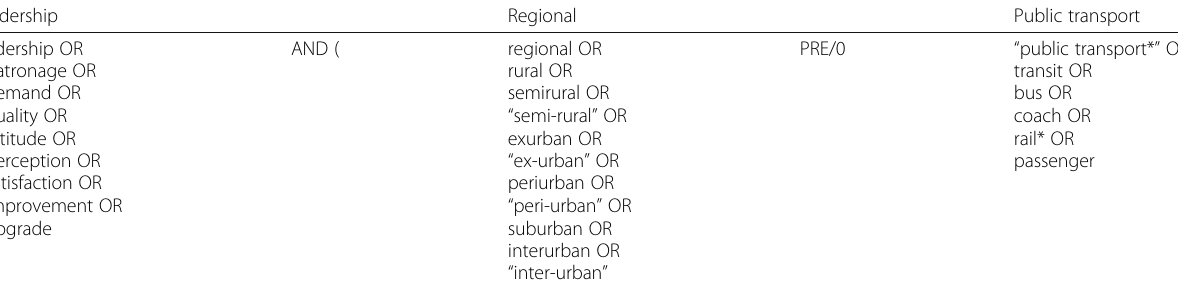
Table 1 Search terms, based on the three concepts ridership , regional , and public transport Ridership Regional Public transport ridership OR patronage OR demand OR quality OR attitude OR perception OR satisfaction OR improvement